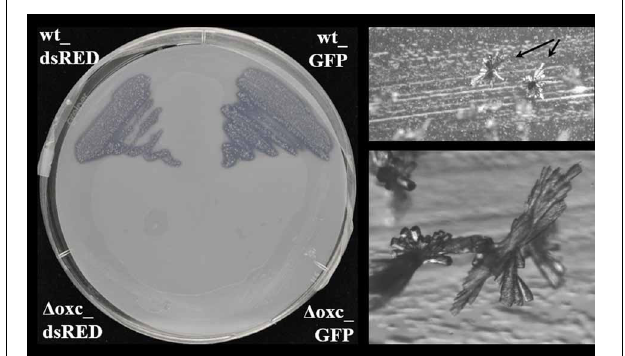
FIGURE 2 | Assessment of oxalotrophy in the dsRed and GFP-tagged wild-type (wt_dsRed respectively wt_GFP) and the accordingly